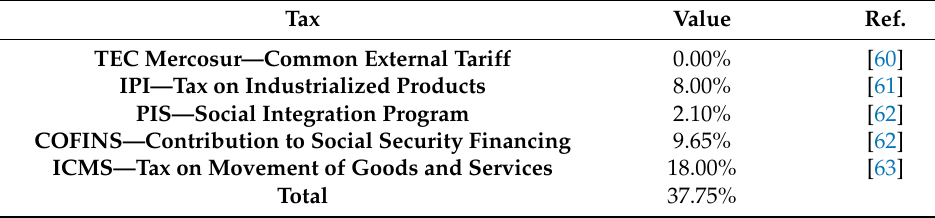
Table 9. Taxes arising from the import of equipment to Brazil.